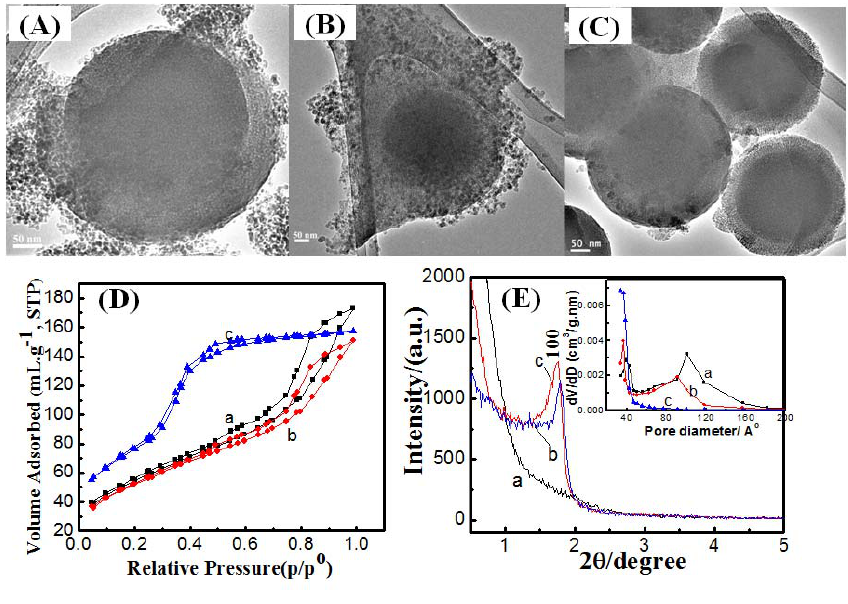
Figure 2. TEM images for mesoporous silica shell constructed on silica cores by two-pot route at synthesis temperature ( A ) 25; ( B ) 50 and ( C ) 80 °C at 20 h reaction time; ( D ) N 2 adsorption/desorption isotherms and ( E ) low X-ray diffraction patterns for mesoporous silica shell constructed on silica cores by two-pot route at synthesis temperature ( a ) 25, ( b ) 50 and ( c ) 80 °C at 20 h reaction time. Inset is the pore size distribution calculated from adsorption